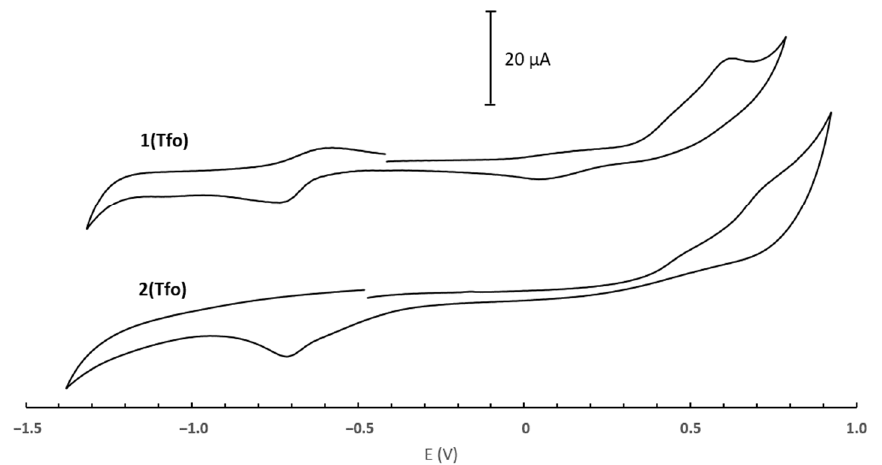
Figure 5. Cyclic voltammograms of complexes measured in CH 3 OH (1 mM solutions) with 0.1 M